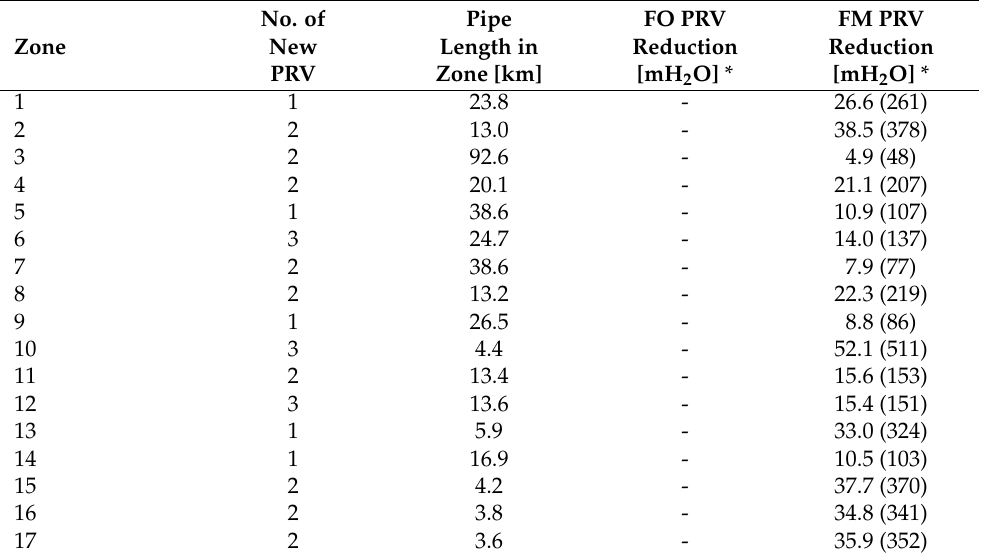
Table 4. Resulting configuration for the 30 most important PMAs in the economically optimal solution identified when considering both FO and FM pressure reduction, ordered by expected leakage reduction if